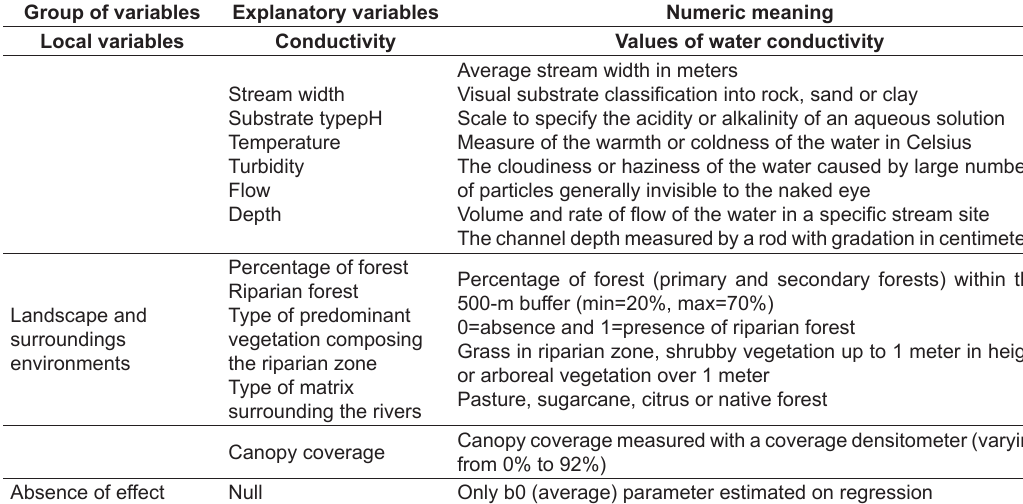
Table 1. Explanatory variables and numeric meaning to explain the occurrence of different ecological groups and species richness of fish in 13 headwaters distributed among four rivers, Cabeça, Corumbataí, Passa Cinco e Ribeirão Claro, in the Rio Corumbataí River Basin, São Paulo State, southeastern